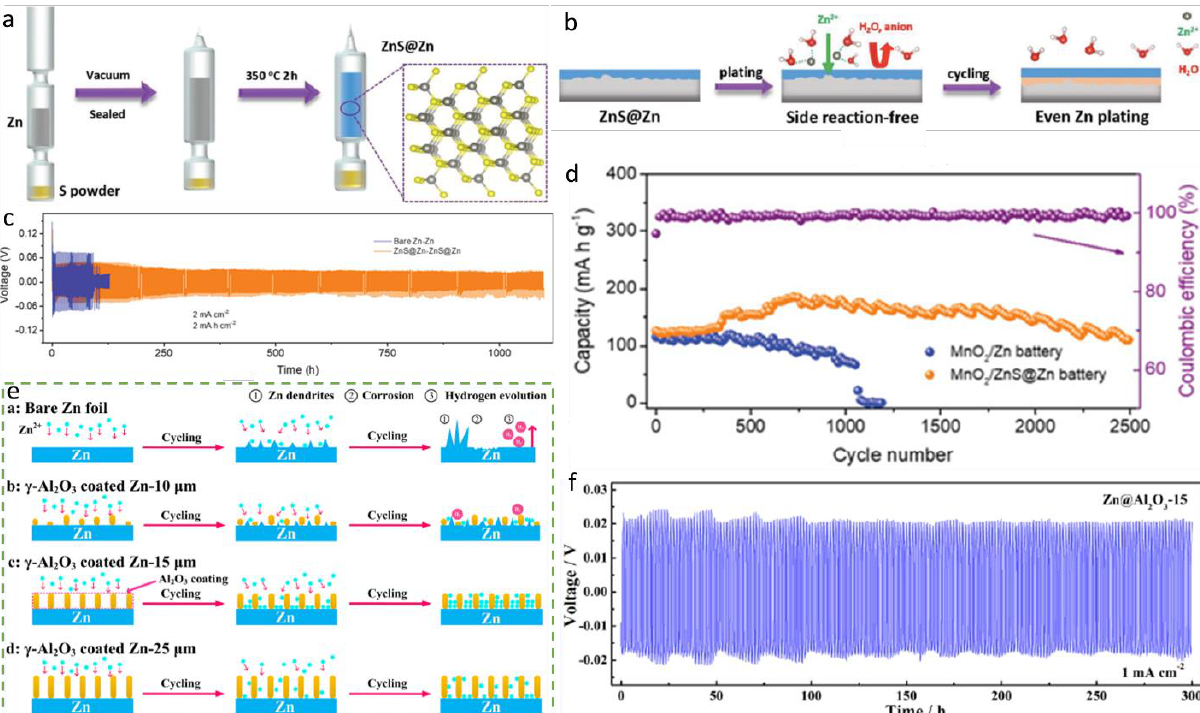
Figure 5. ( a ) Schematic illustrations for preparing ZnS coated Zn foil. ( b ) Mechanism of anti-dendrite and blocking site reactions of ZnS during plating process. ( c ) Cycling performance of symmetric Zn ǁ Zn and ZnS@Zn ǁ ZnS@Zn cells. ( d ) Specific capacity and Coulombic efficiency of Zn/ZnS@Zn-